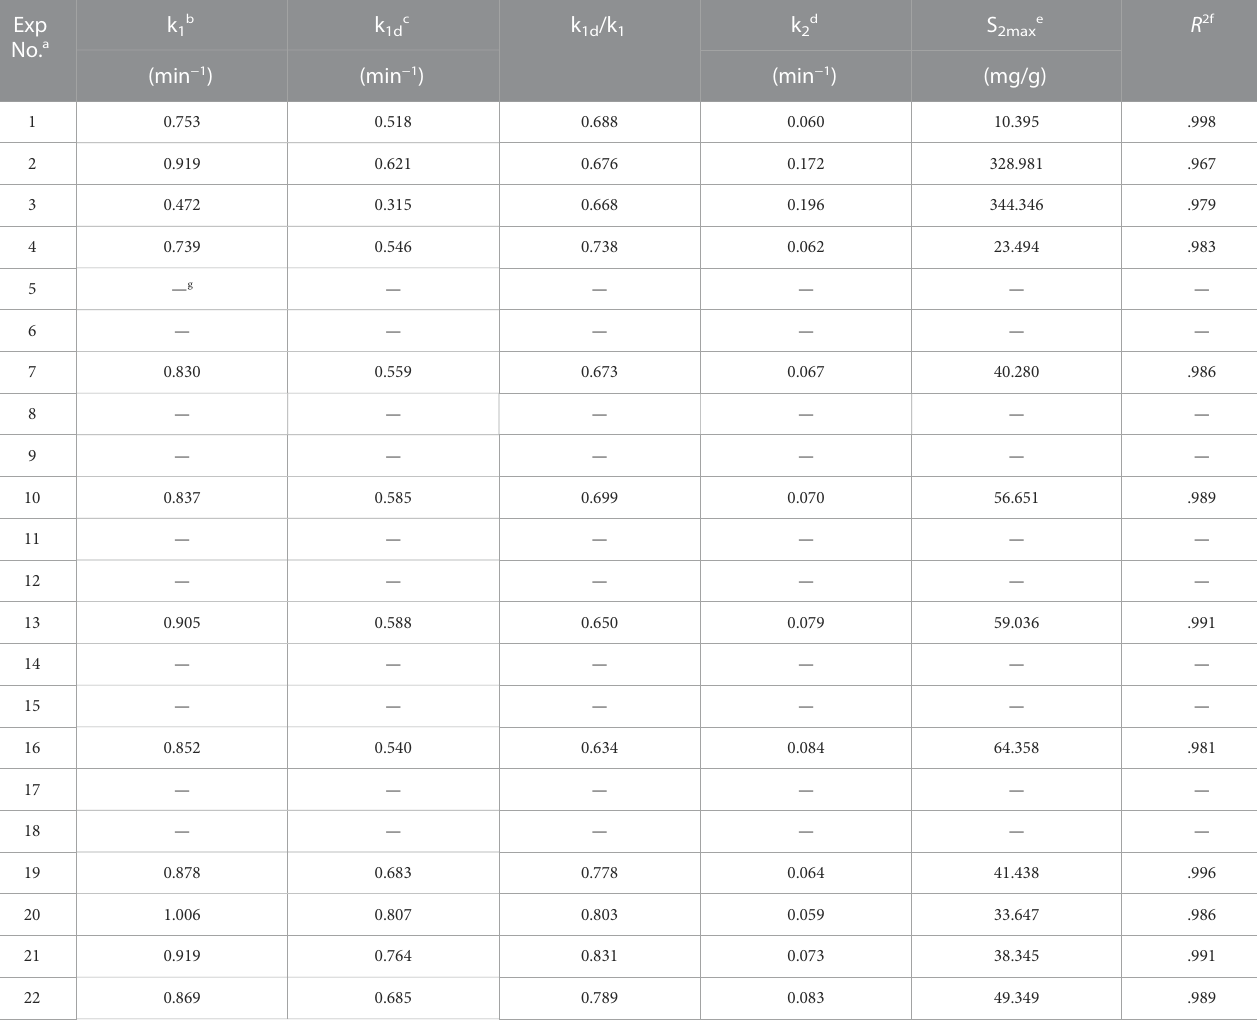
TABLE 2 Fitted parameters of the two-site kinetic retention model estimated for soil-packed columns at different experimental conditions. Exp No.